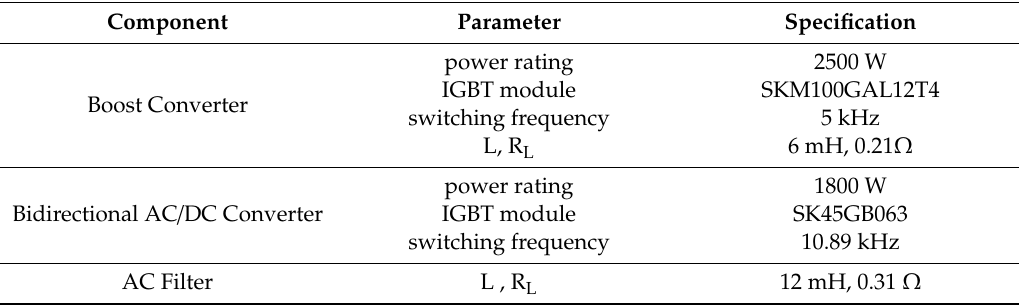
Table 1. The experimental setup